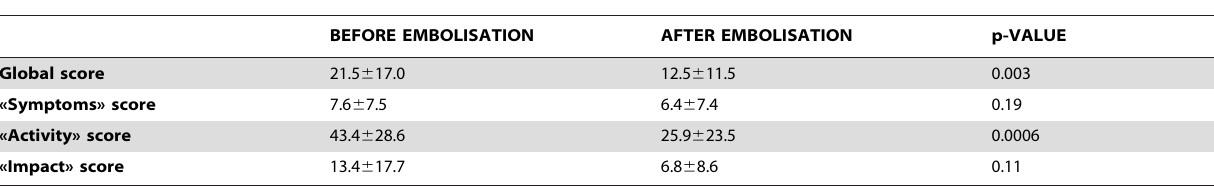
Table 3. Impact of embolisation on quality of